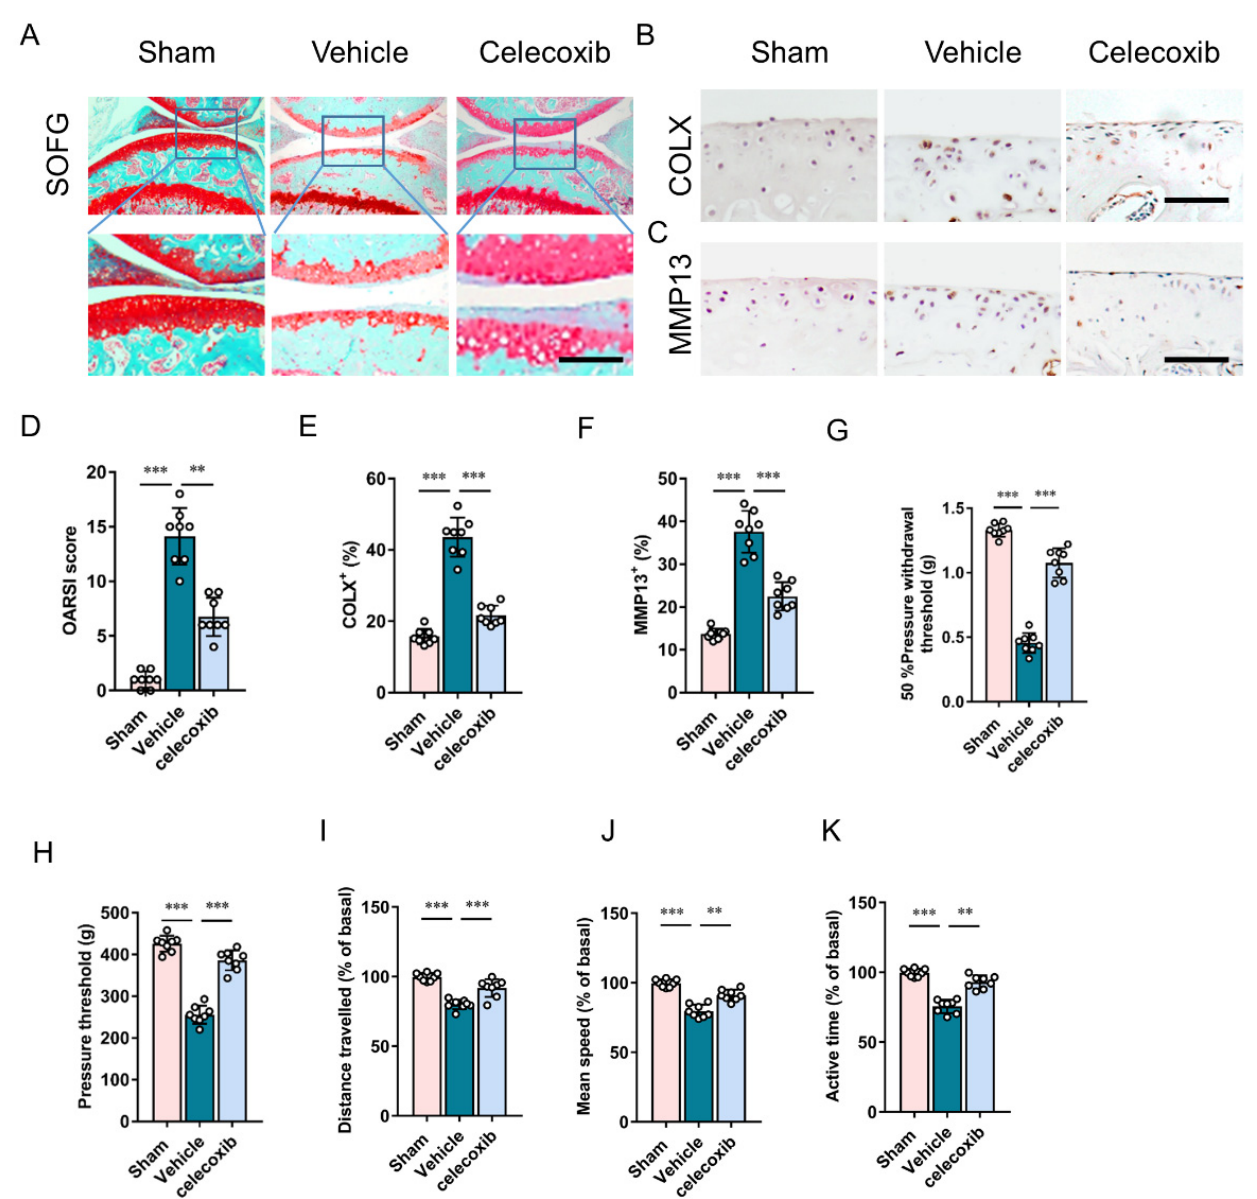
Figure 3. Inhibition of PGE2 prevents joint osteoarthritis degeneration and pain. ( A ) SOFG staining of the medial compartment of subchondral bone (sagittal view) at eight weeks following surgery. Scale bar: 50 μ m. ( B , C ) Immunostaining of ColX+ ( B ) and MMP13+ ( C ) chondrocytes in